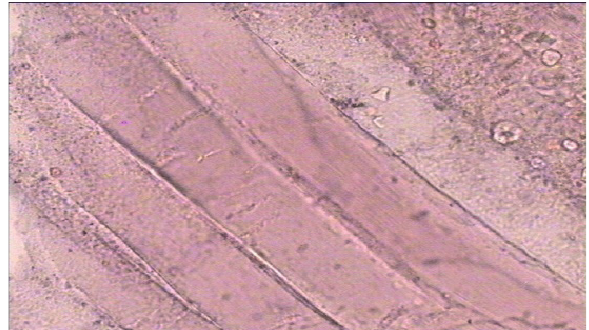
Figure 1 Microstructure of the control sample (340×magnifi- cation)